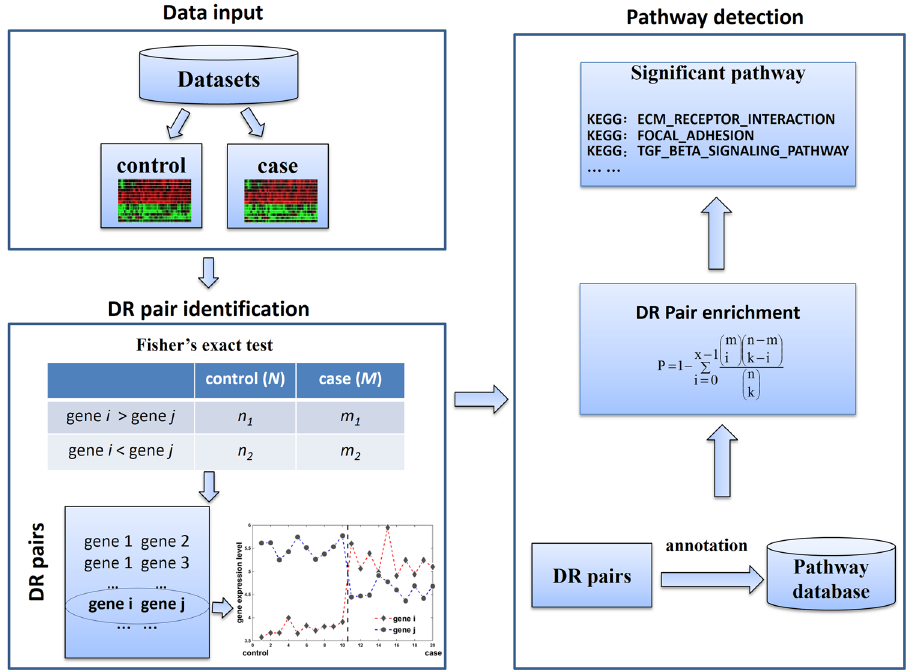
Figure 1. Flowchart of DRFunc . The DRFunc algorithm includes three steps: input of expression profiles for case and control samples (from the same or different experiments), DR gene pair identification, annotation and detection of significant